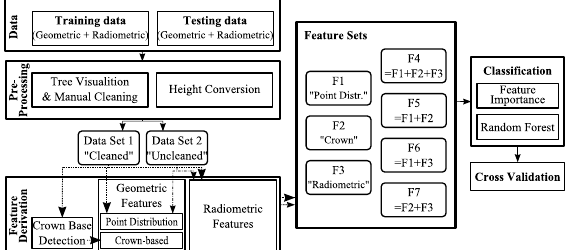
Figure 1. Workflow to classify tree families using derived geometric and radiometric features from FWF point cloud data.